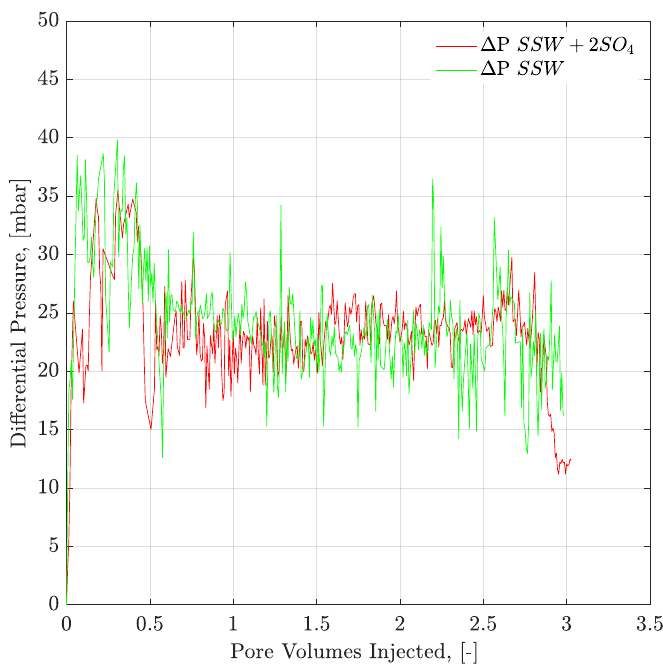
Figure 9. Pressure response of secondary mode brines flood through six weeks aged Bentheimer core plugs at flux rate of 1 ft/day. ΔP SSW + 2SO 4 represents the pressure drop for synthetic seawater with doubled amount of sulfate and ΔP SSW represents the pressure drop for synthetic seawater.